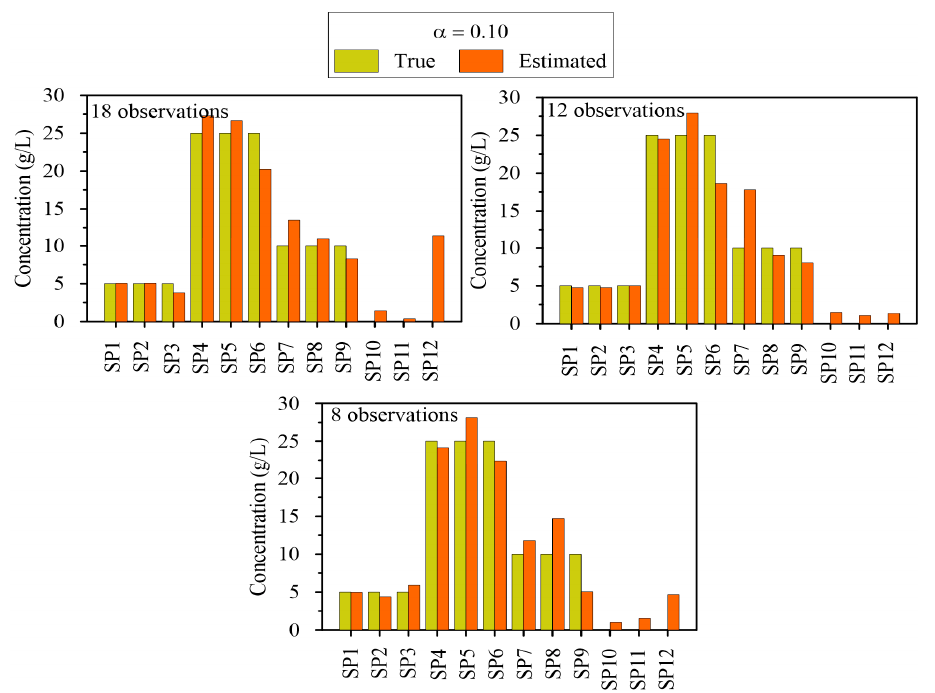
Figure 16. Source release histories in error-perturbed data condition ( α = 0.1) with 18, 12 and 8 observed concentrations data.